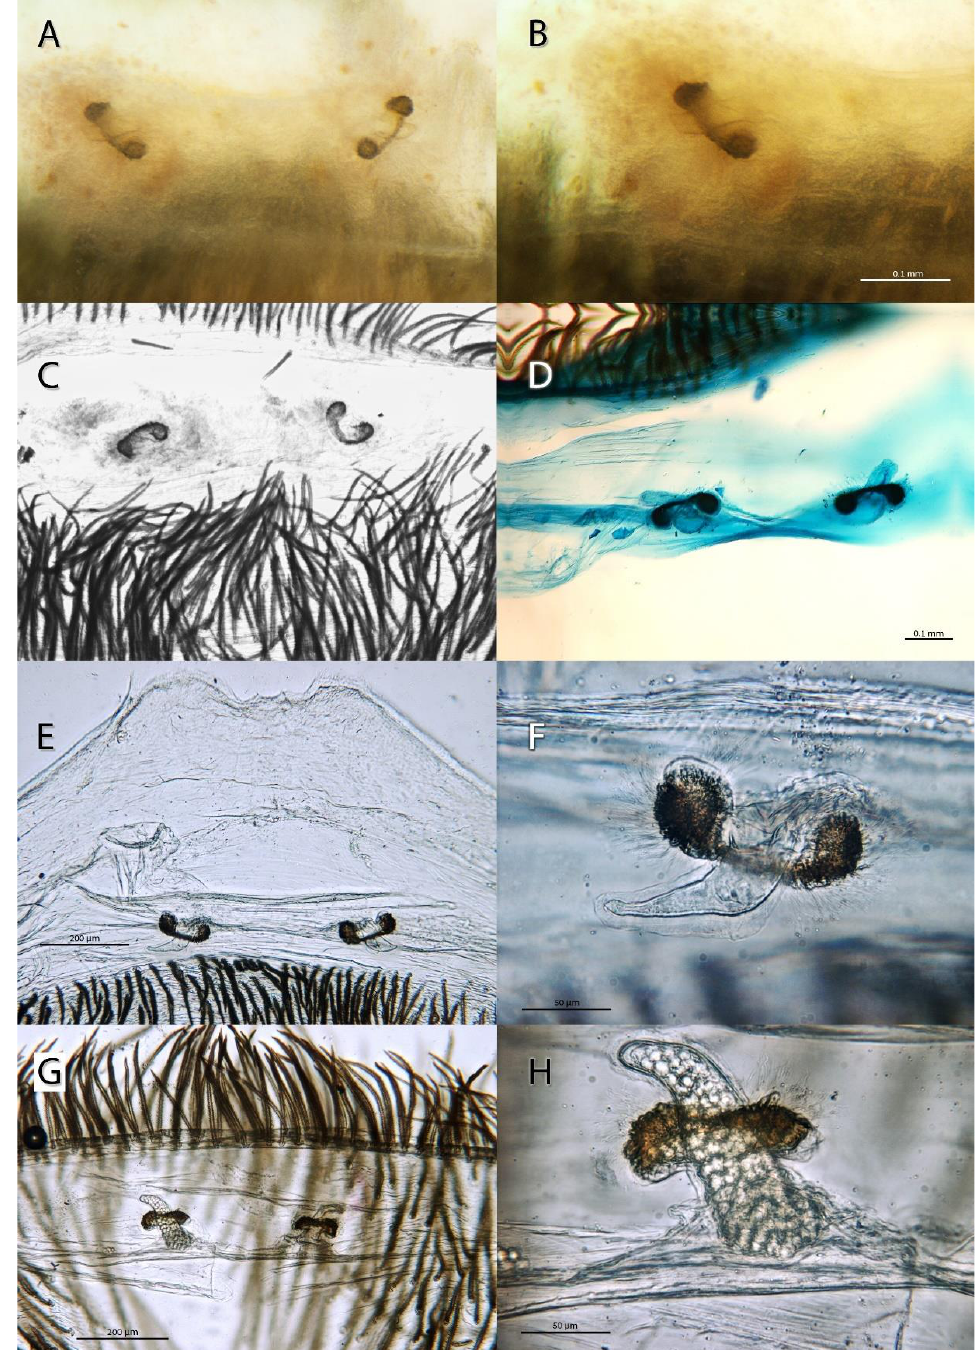
Figure 10. Sahastata aravaensis sp. nov. female endogyne. ( A – C ): Holotype HUJI-AR 20302, Pictures: Zeana Ganem, ( D ): paratype SMNH, Picture: Sergei Zonstein, ( E , F ): paratype MACN-Ar 41837, ( G , H ): paratype SMF. Pictures: Ivan L. F. Magalhaes.